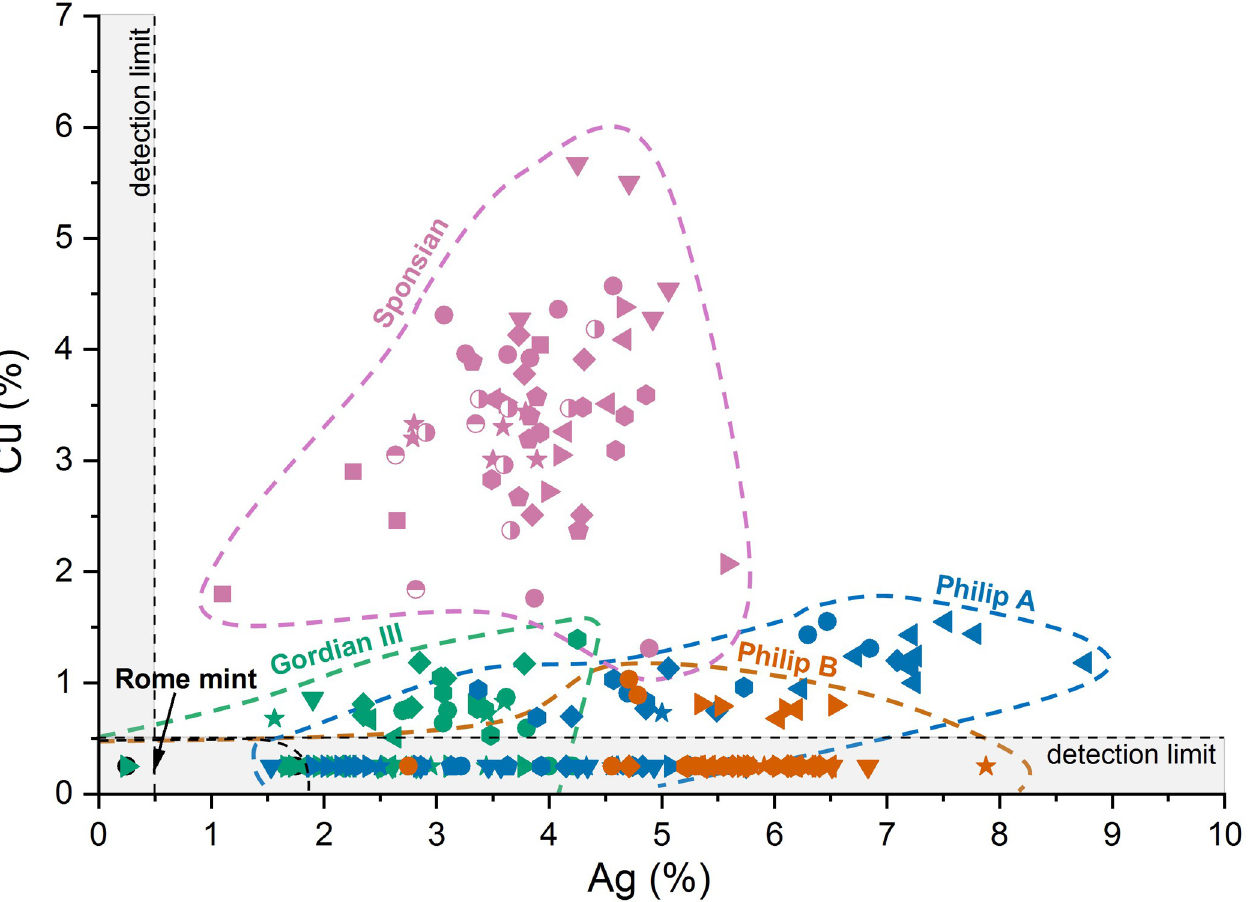
Fig 4. Variation of silver and copper content of the six coins analysed in this study by SEM-EDX point analyses. Gordian III = GLAHM:29596; Philip A = GLAHM:29820; Philip B = GLAHM:29821; Sponsian = GLAHM:40333. Different symbols refer to different zones within each coin; each point is a different surface analysis. For each coin, circles = zone 1, down triangles = zone 2, diamonds = zone 3, left triangles = zone 4, right triangles = zone 5, hexagons = zone 6, stars = zone 7, pentagons = zone 8, squares = zone 9, horizontal half-filled circles = zone 10, vertical half-filled circles = zone 11. Coins of the Rome mint have no detectable copper and either low or undetected silver. Data are presented by coin and zone in S5 File and average compositions are given in Table 3.